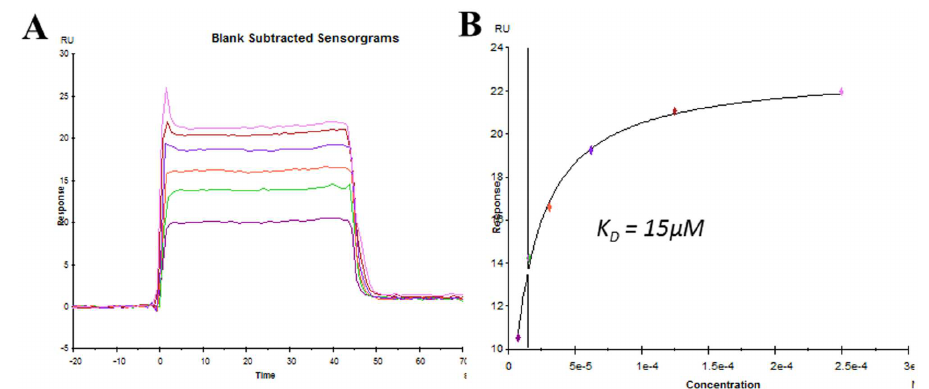
Fig 5. Measurement of binding of BBP to eIF4E by SPR. Purified eIF4E was immobilizedto the Fc2 channelof a CM5 sensor chip as the ligand. The immobilization was performed through amine-coupling reaction. Fc1 channelwas treated similarlybut without protein as the control. Different concentrations of BBP were appliedthrough Fc1 and Fc2 channels as the analyte to measurethe binding. (A) Adjusted sensorgrams (Fc2-Fc1) showingthe bindingof eIF4E to variousconcentrations of BBP. (B) Calculationof bindingaffinity using steady-state fitting model.